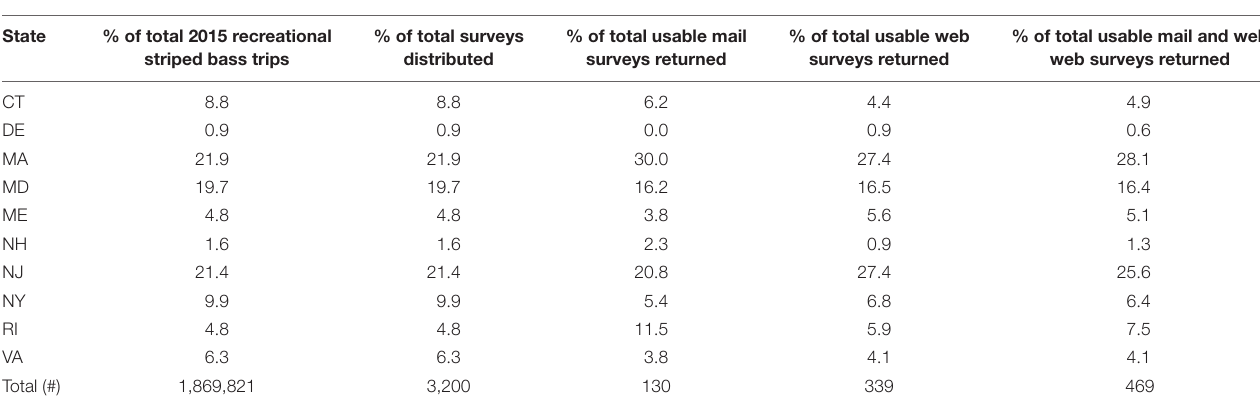
FIGURE 3 | Map of the 10 coastal states included in the survey sampling frame. Simulation model is calibrated to 2015 fishing conditions in Massachusetts, Rhode Island, and Connecticut. TABLE 2 | 2015 striped bass trips, surveys distributed, and surveys returned by